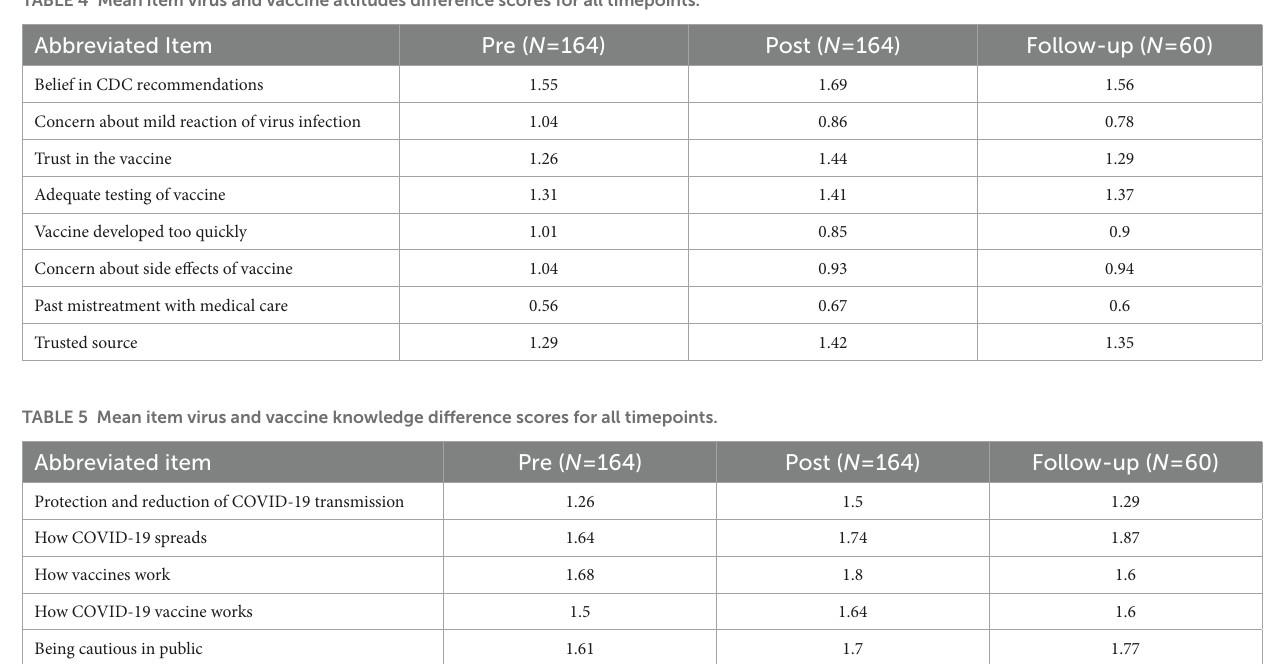
TABLE 4 Mean item virus and vaccine attitudes difference scores for all